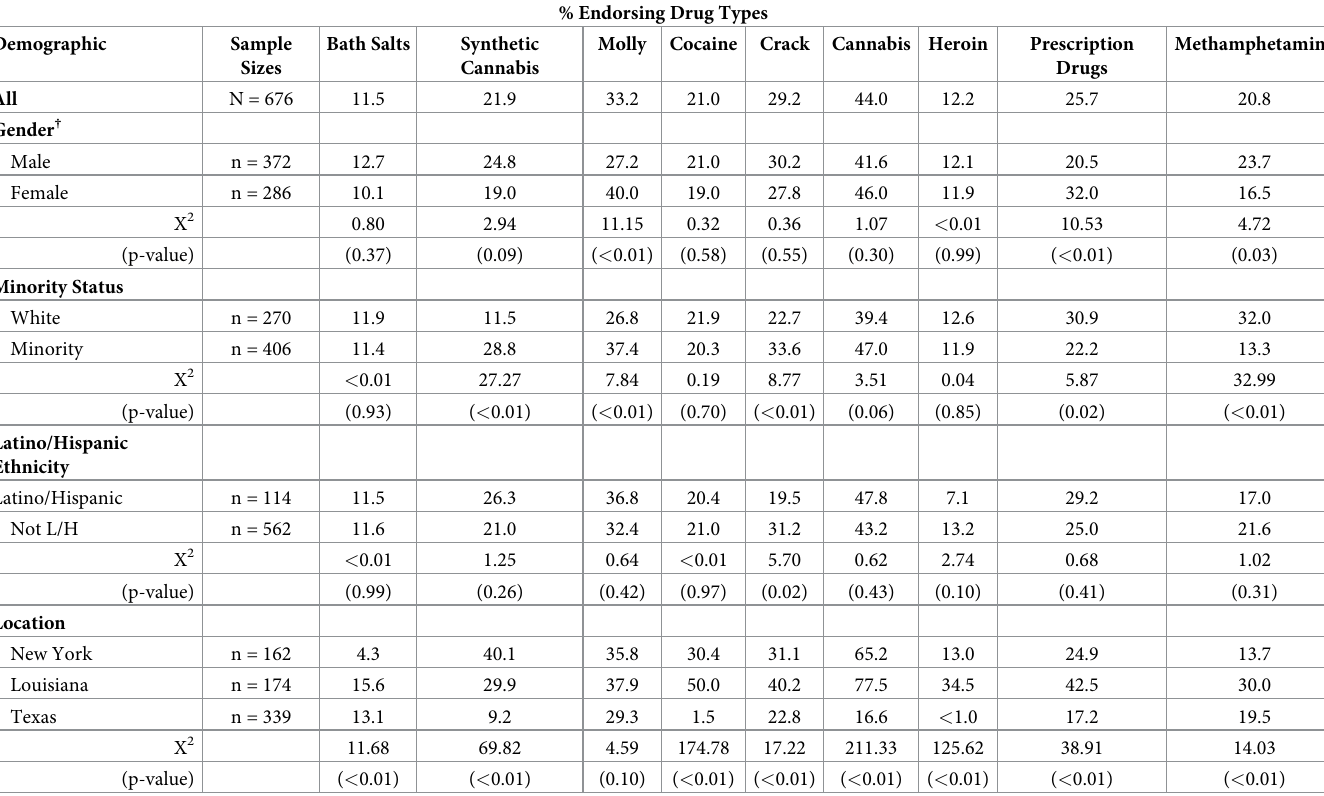
Table 2. Past 30-day drug use prevalence stratified by gender, minority ethnic status, and